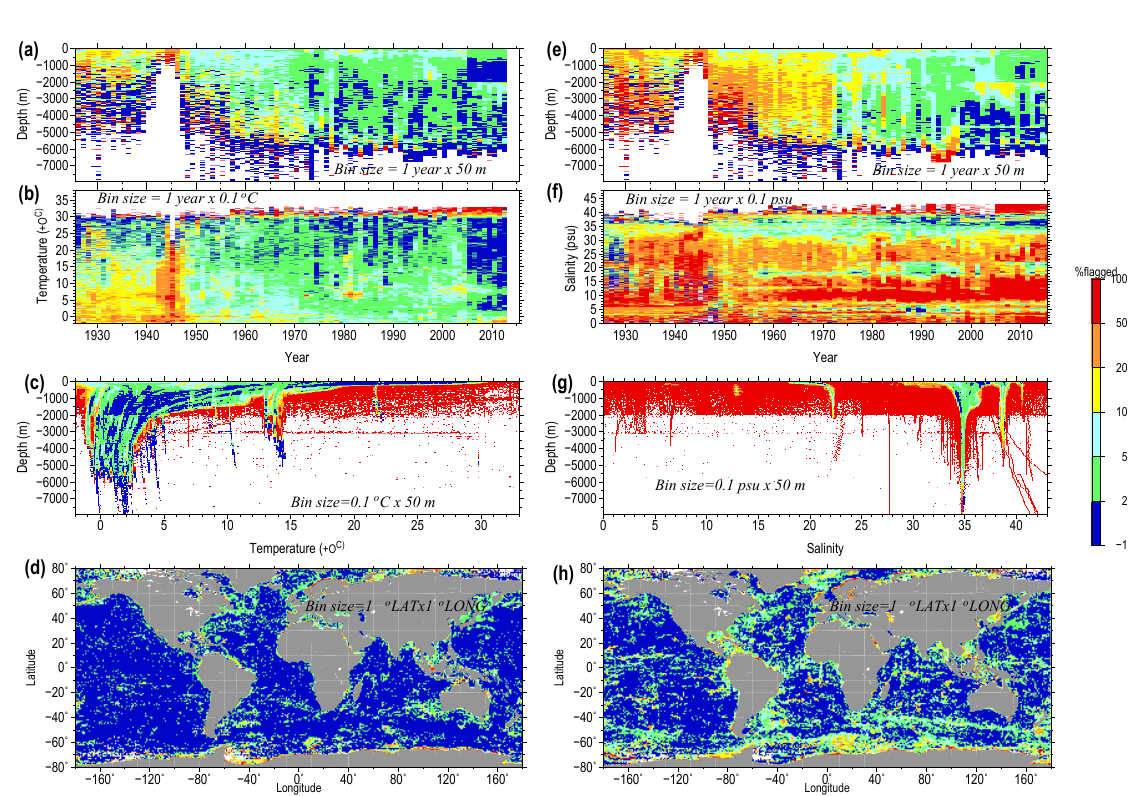
Figure 2. Temperature (a–d) and salinity (e–h) data rejection rates (all instrument types).